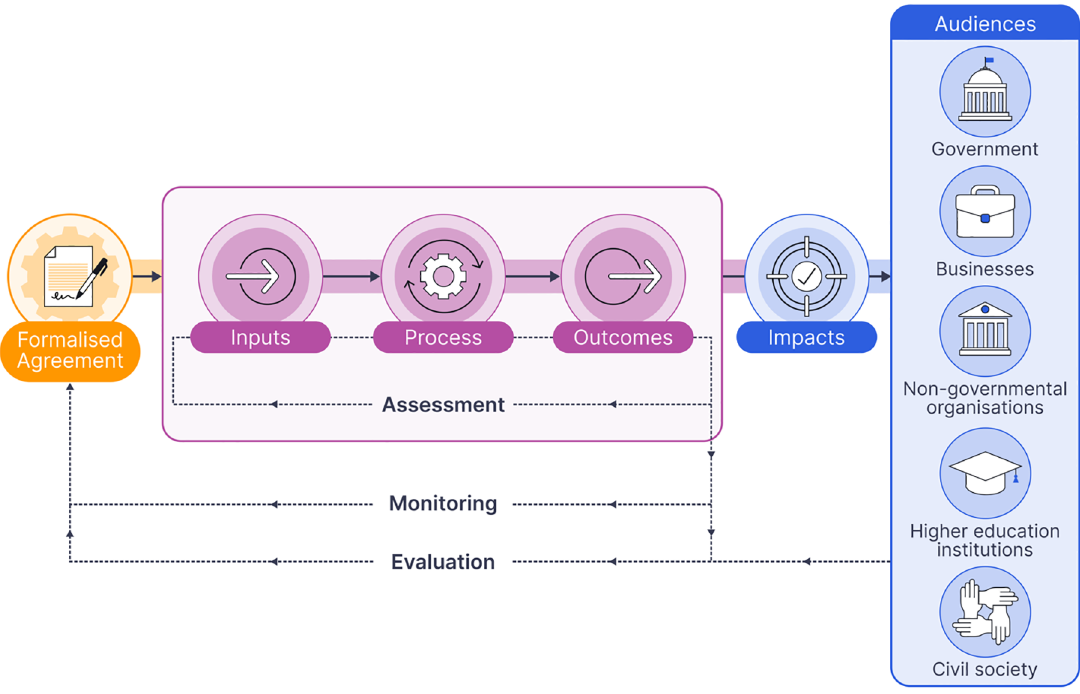
A conceptual framework to appraise success of HEI-community partnerships (adapted from Plummer et al.